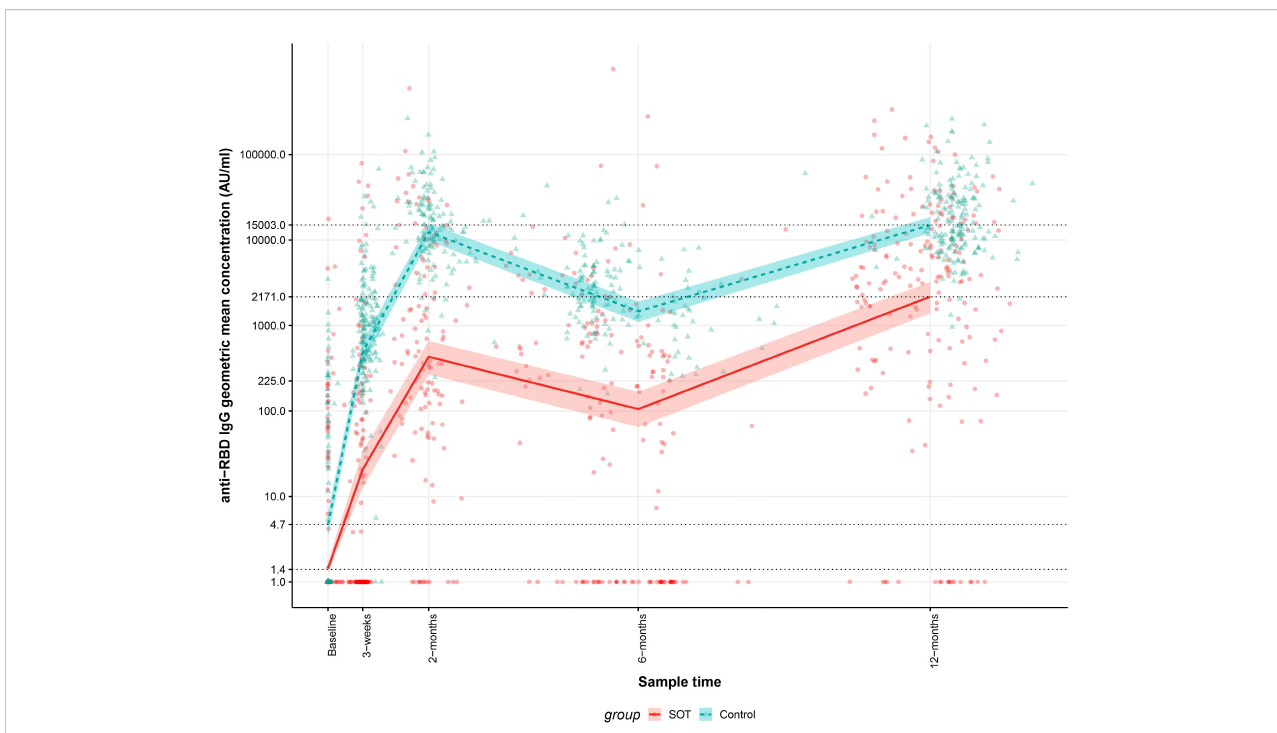
FIGURE 1 Kinetics of the modeled anti-receptor-binding domain (RBD) Immunoglobulin G (IgG) geometric mean concentrations (GMCs) in solid organ transplant (SOT) recipients and controls within 12 months after the fi rst BNT162b2 dose and observed anti-RBD IgG concentrations. The data include 189 SOT recipients (red) and 189 age and sex matched controls (blue). The modeled anti-RBD IgG GMCs in AU/mL with 95% con fi dence intervals are plotted on top of each individual sample ’ s measured anti-RBD concentration in AU/mL. The y-axis is on a log10 scale. The dashed horizontal lines indicate modeled anti-RBD IgG GMC values for SOT recipients and controls at baseline and 12 months after the fi rst BNT162b2 dose.